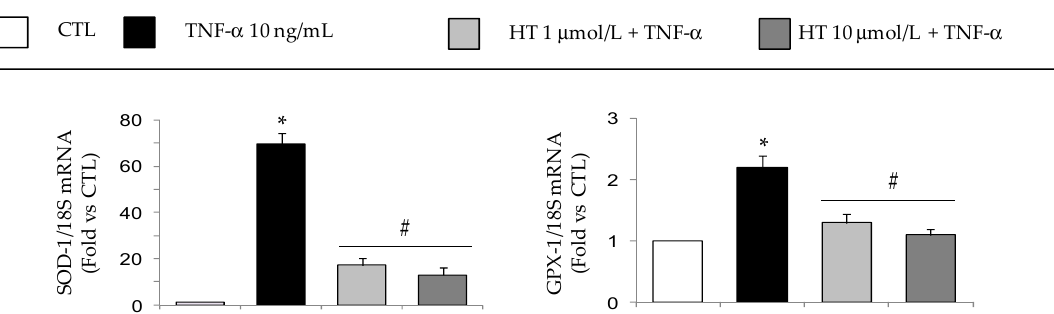
Figure 2. Modulation by HT of mRNA expression levels of genes associated with antioxidant response. SGBS adipocytes were pretreated with HT (1 h) at the concentrations indicated, and then treated with 10 ng/mL TNF- α for 18 h. Total RNA was extracted from cells, and mRNA levels of SOD-1 and GPX-1 were measured by qPCR using specific primers and probes and normalized to 18S RNA. Data (means ± SD, n = 3) are expressed as fold induction over untreated control (CTL). * p < 0.05 vs CTL. # p < 0.05 vs TNF- α alone.